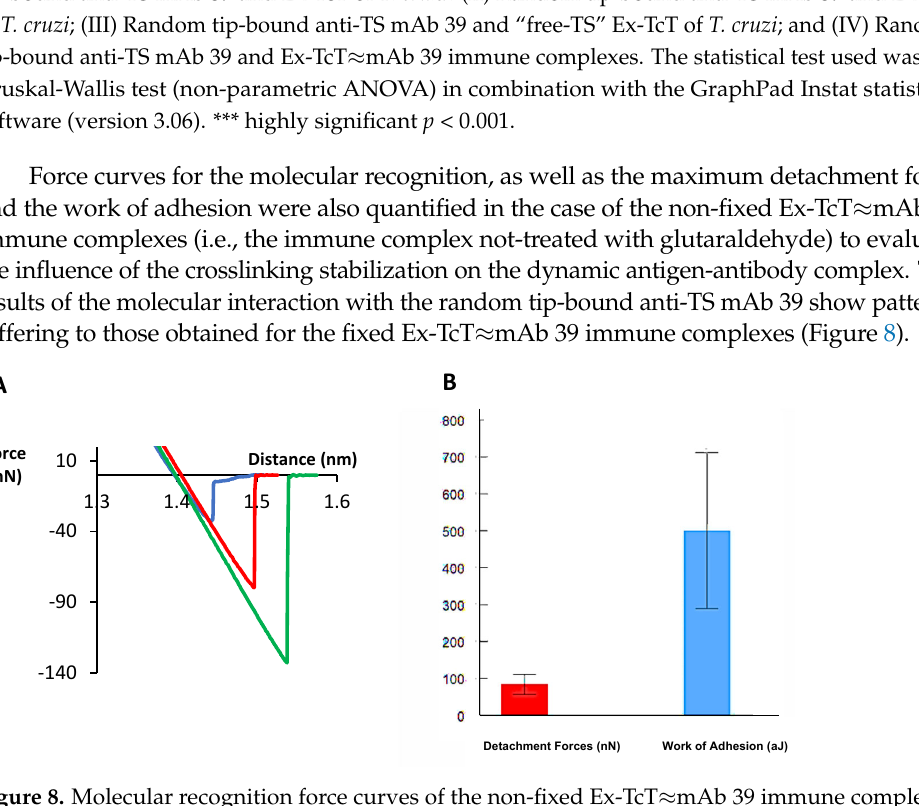
Figure 8. Molecular recognition force curves of the non-fixed Ex-TcT ≈ mAb 39 immune complexes. ( A ) Red, blue, and green lines represent three different patterns of interactions with the random tip ‐ bound anti ‐ TS mAb 39 and Ex ‐ TcT ≈ mAb 39 immune complexes. ( B ) Mean values of maximum adhesion force and work of adhesion.